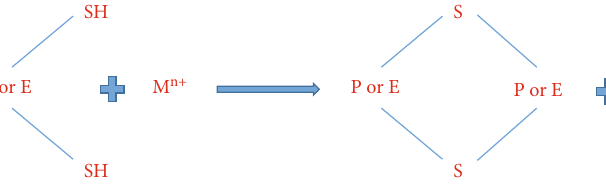
Figure 3: Enzyme suppression by toxic metal in human